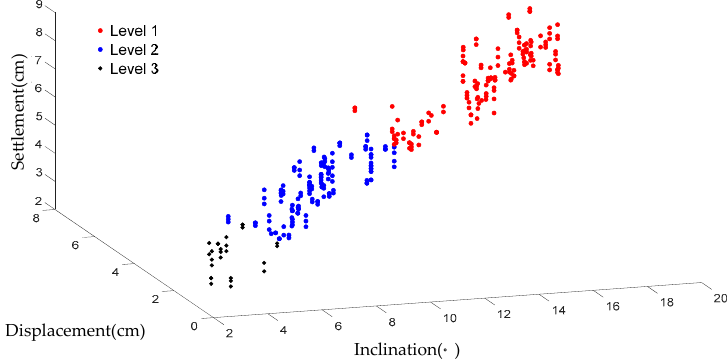
Figure 16. The damage level classification result predicted by KNN-SVM.